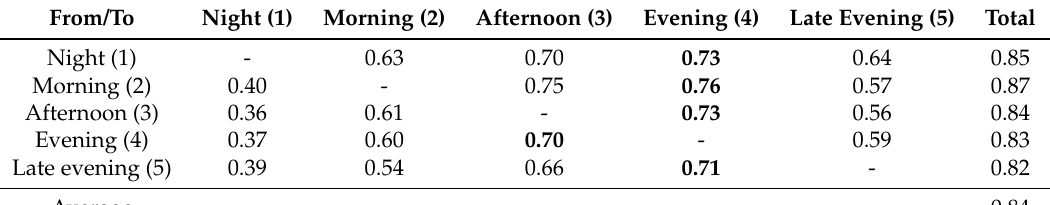
Table 9. Detection rate of the predictor per time slot for MD dataset. The best results per origin time slot are marked in bold.